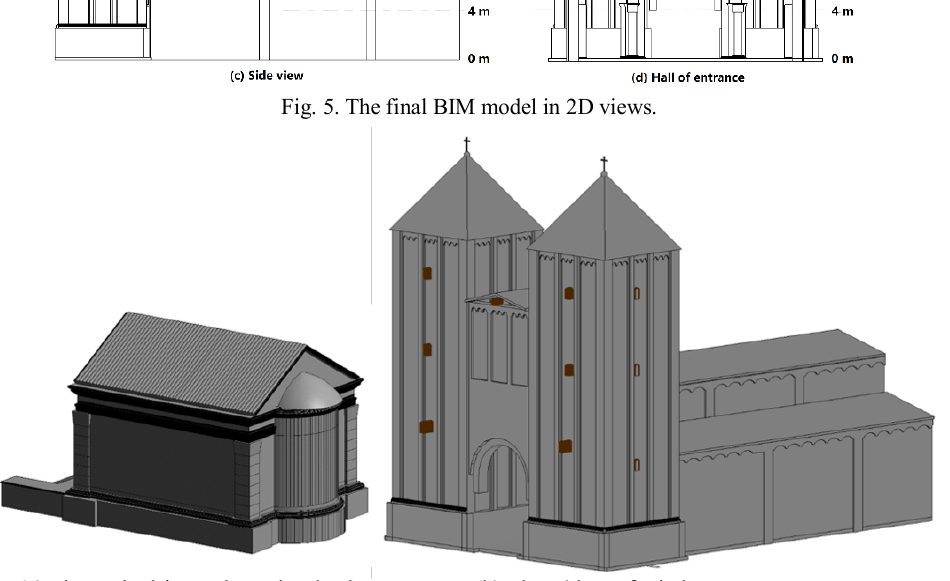
Fig. 5. The final BIM model in 2D views.